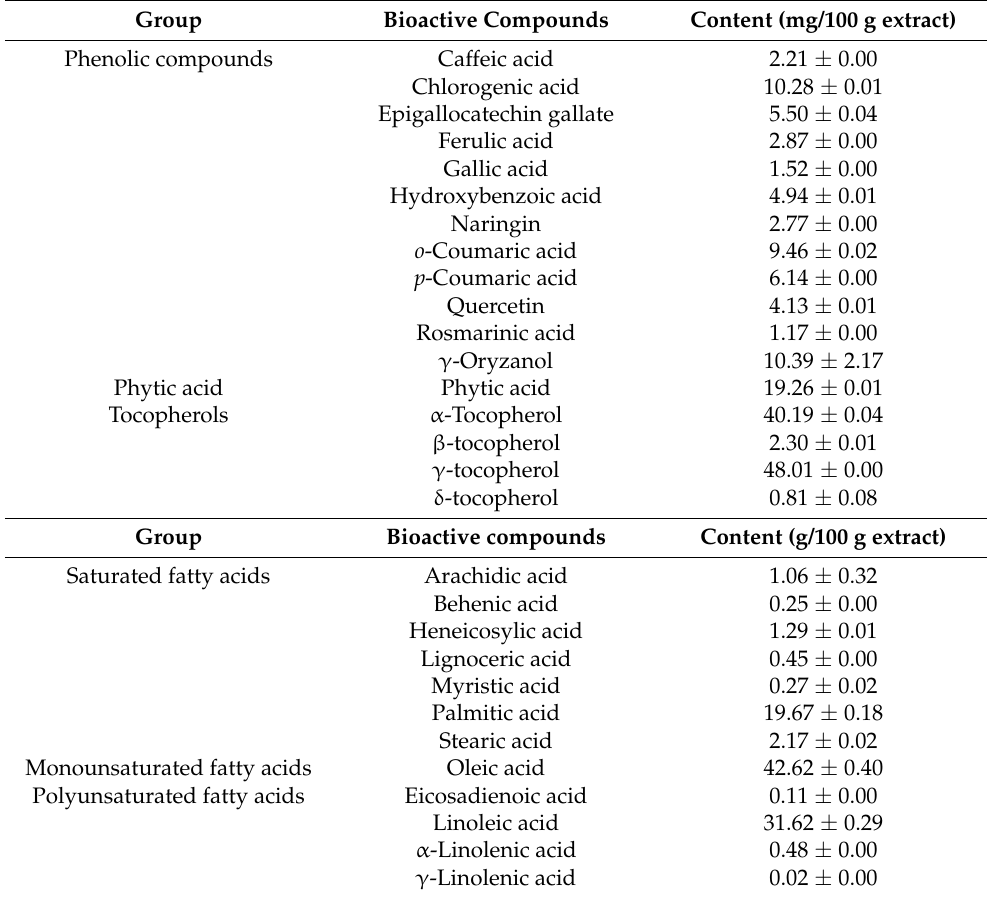
Table 2. The contents of bioactive compounds in KDML105 bran